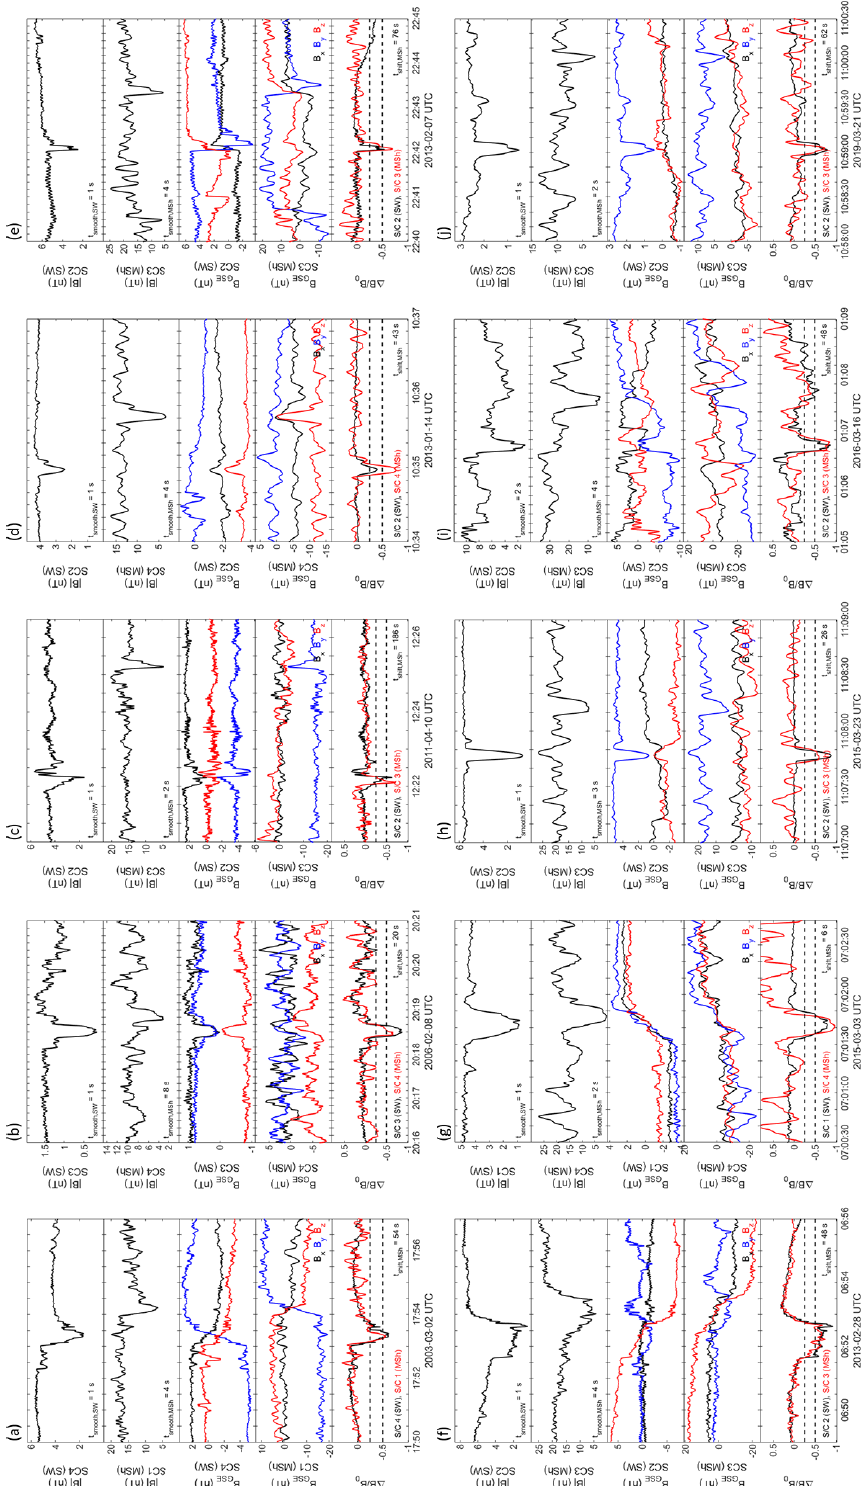
Figure 4. Ten different examples of simultaneous observation of magnetic holes in the solar wind and the magnetosheath. Each event is shown in the same format: magnetic field strength for the solar wind (SW) and magnetosheath (MSh) spacecraft, magnetic field components for the same spacecraft in GSE coordinates, and comparison of (cid:49)B for the solar wind (black) and magnetosheath (red) spacecraft. The B 0 magnetosheath measurements of (cid:49)B have been B 0